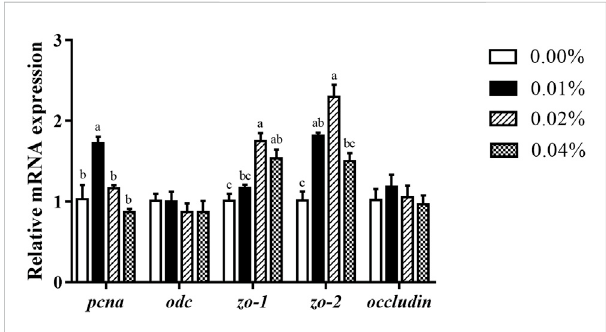
FIGURE 3 Effectsofsupplementalfulvicacidonintestinalcell proliferation- related and barrier-related genes mRNA expression in intestine of large yellow croaker larvae (mean ± S.E.M, n = 3). Pcna , proliferating cell nuclear antigen; odc , ornithine decarboxylase; zo-1 , zonula occludens-1; zo-2 , zonula occludens-2. Bars with different letters showed a signi fi cant difference ( p < 0.05, Tukey ’ s test).